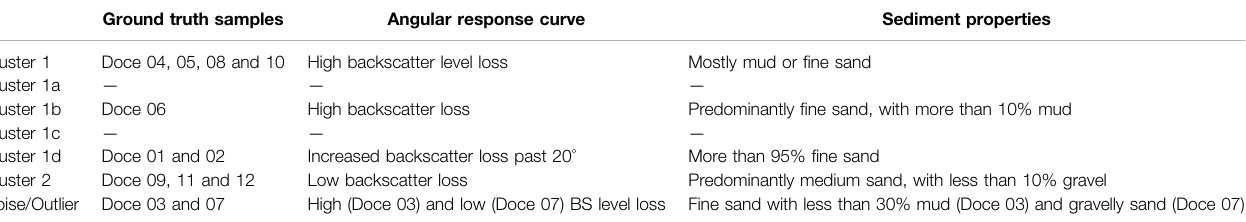
TABLE 1 | Characteristics of each cluster. Ground truth